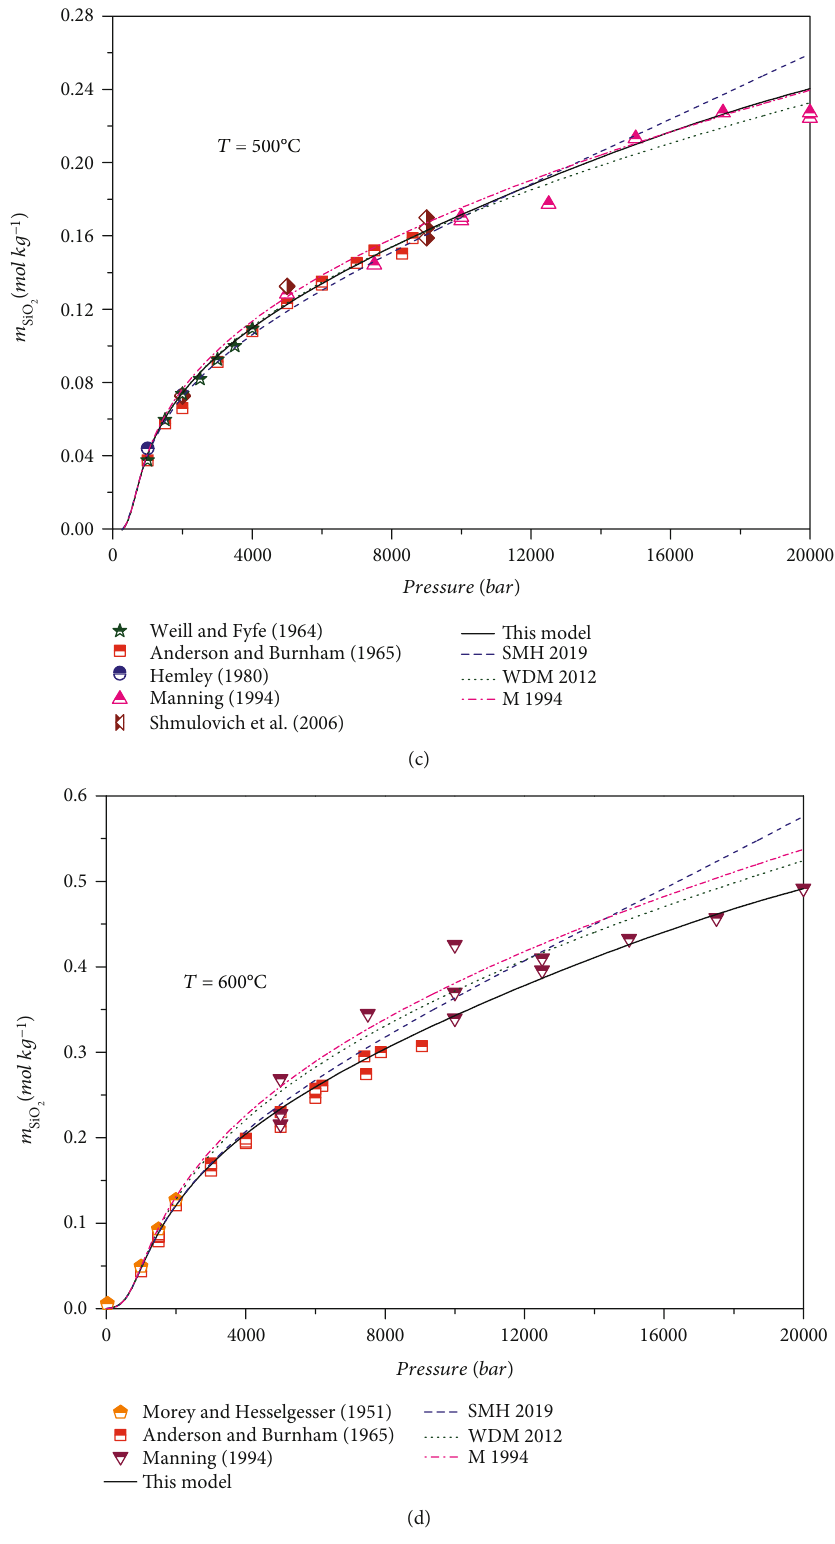
Figure 2: Model predictions of quartz solubility in pure water and the comparisons between di ff erent model computes and experimental data sets. Symbols represent experimental data, and curves are the predictions of di ff erent